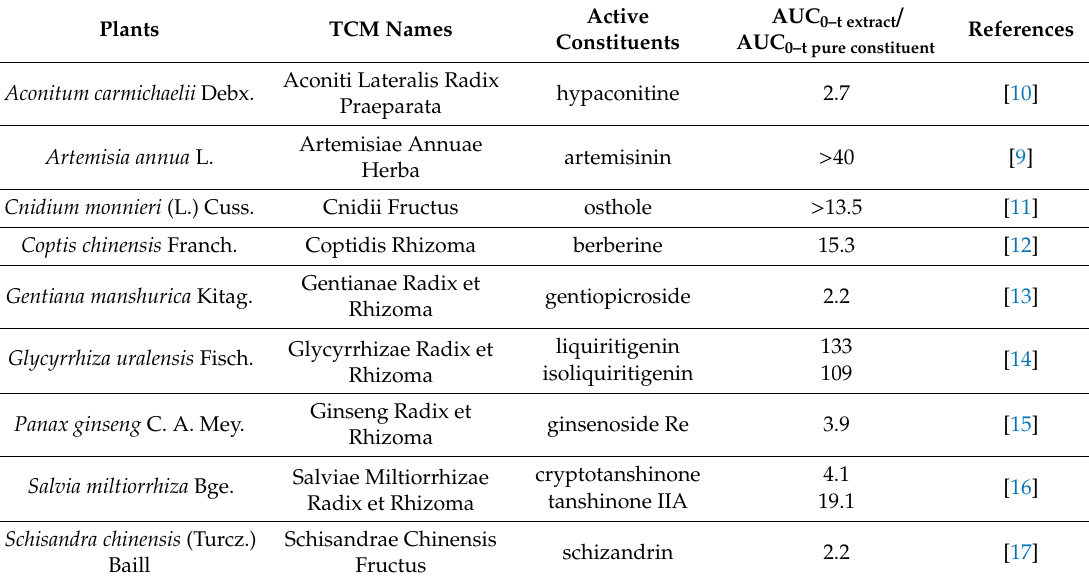
Table 1. Pharmacokinetic di ff erences between some herbal extracts and their pure constituents. Plants TCM Names